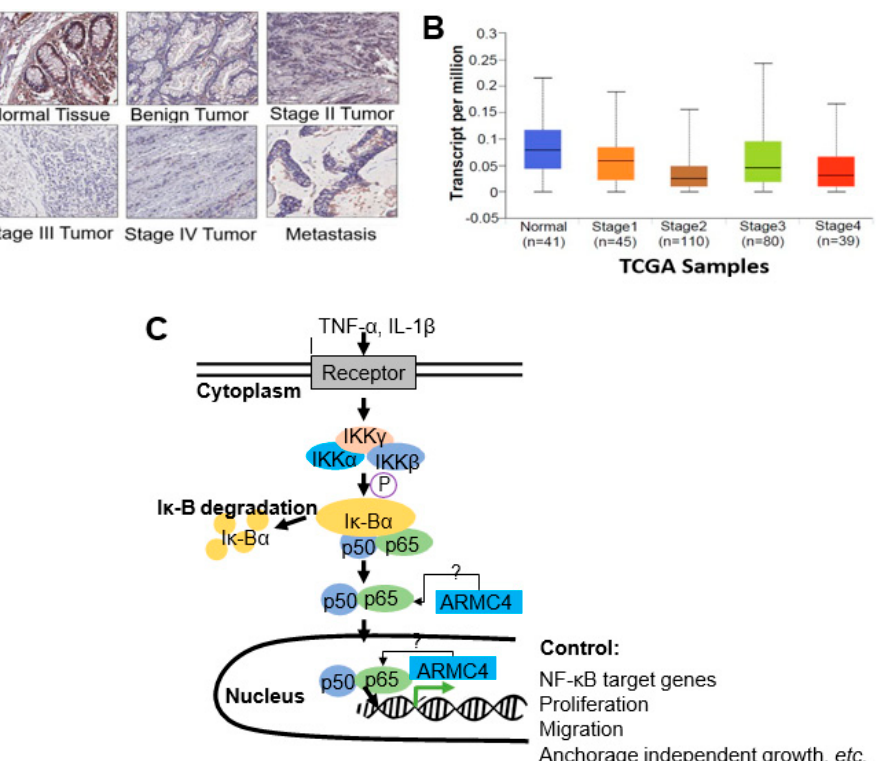
Figure 7 . ARMC4 expression is decreased in CRC patient specimens. ( A ) Tissue microarray (TMA) using ARMC4 antibody as the probe, showing strong expression of ARMC4 in normal tissue, while significantly decreased expression in different stages of CRC and the metastasized patient tumor samples. ( B ) Data gathered from TCGA databases, showing ARMC4 transcripts trend toward decreased levels in different stages of CRC as compared to normal samples. ( C ) Hypothetical model, suggesting that ARMC4 may form a complex with the NF- κ B, thus exert negative regulation effect on the hallmarks of cancer regulated by NF- κ B. In traditional pathway, upon cytokine stimulation, the I κ B kinase phosphorylates I κ B α , causing degradation of I κ B. The free p65/p50 heterodimer then migrates to the nucleus to bind to κ B-binding sites on the promoters of specific genes, leading to their activation. Our findings suggest ARMC4 may complex with NF- κ B downstream of I κ B α ,